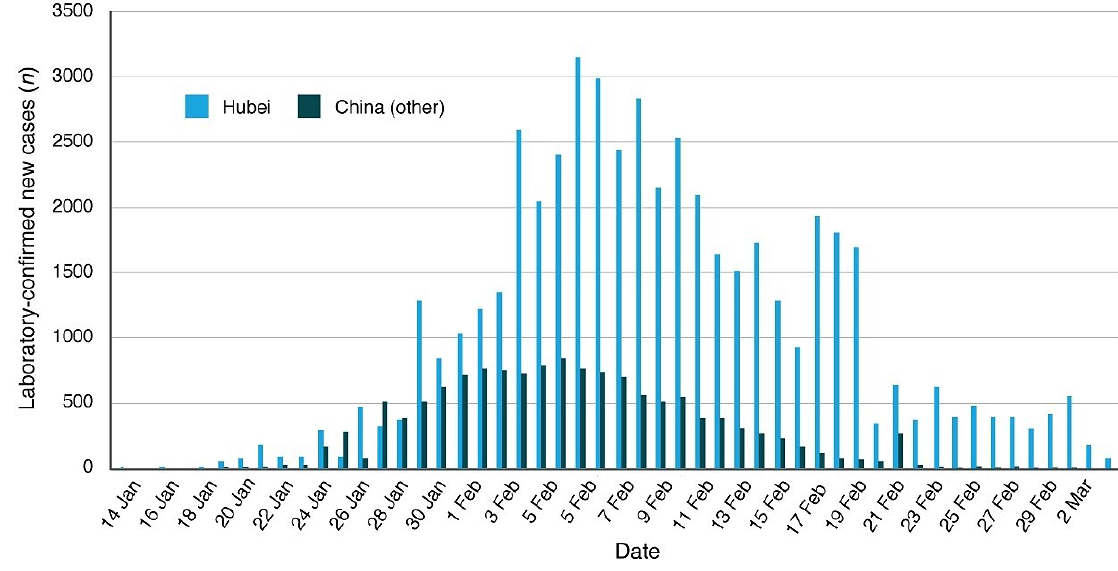
Figure 4. COVID-19 epidemic curve in Hubei and the rest of China. Data sourced from media reports, ProMED-Mail and WHO situation reports. (Adapted from